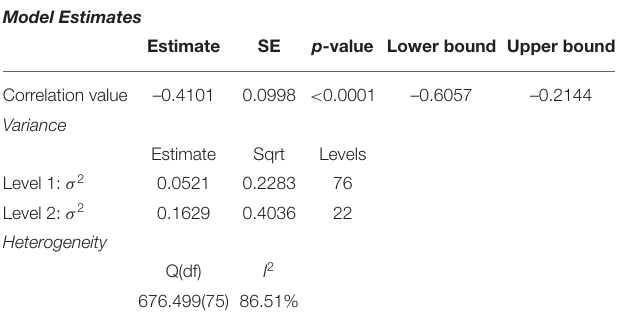
TABLE 3 | Model 2: Meta-regression results.